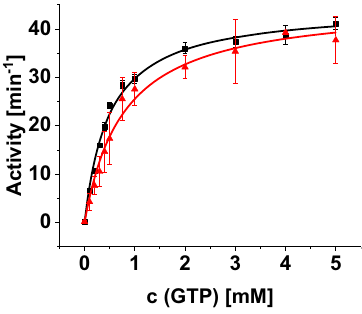
Fig. 6 | Lipid-stimulation of the Syn DLP GTPase activity. Syn DLP GTPase activ- ities in the presence and absence of LUVs were determined in a continuous, regenerative, coupled assay. Comparison of Syn DLP under standard measurement conditions (black) and with 50 µ M DOPG LUVs (dissolved in reaction buffer, extrusionto100nm)addedwiththeassaycomponents(red).Meanofindependent experiments ( n =3) and error bars (S.D.) are shown. Data points were fi tted using the Michaelis-Menten equation (Eq. (2)). Fit curves are shown as